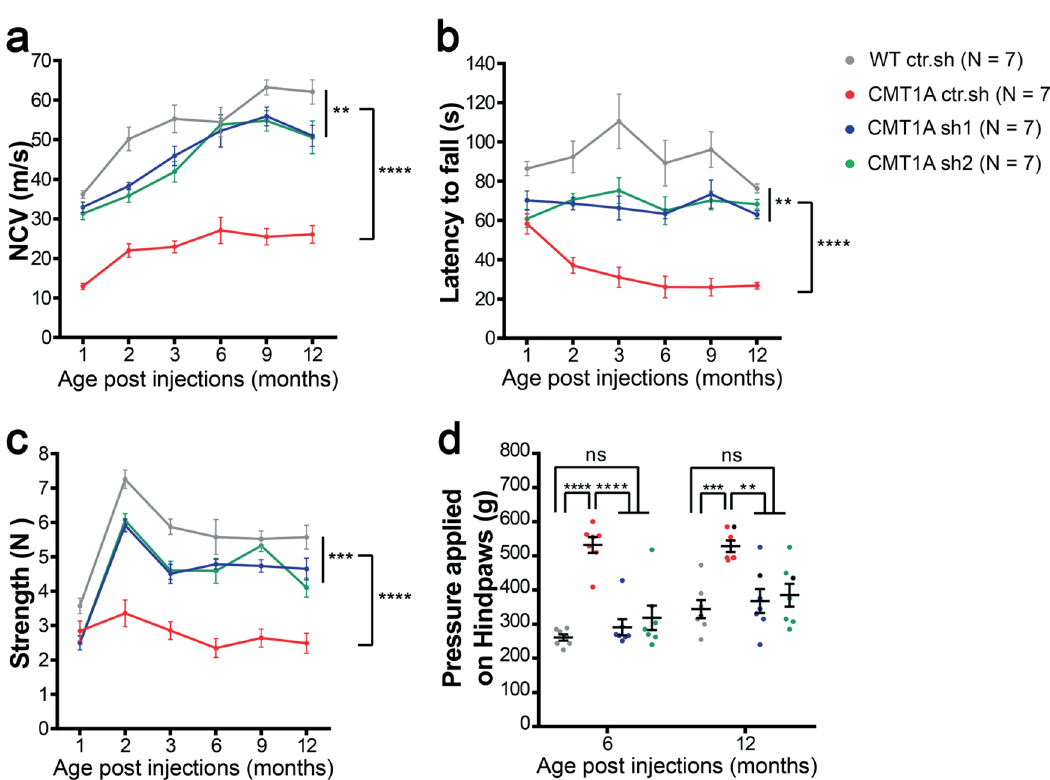
Fig. 5 Intra-nerve injections of AAV2/9-sh1 and -sh2 prevent motor and sensory defects on the long term in CMT1A rats. Graphs showing a NCV (meter/second), b Rotarod test (second), c grip test (Newton) one to twelve months after injection and d Randall Selitto test (gram) six and twelve months after injection in WT ctr.sh, CMT1A ctr.sh, CMT1A sh1 and CMT1A sh2 animals ( n = 7 animals per group). Statistical analysis shows two-way ANOVA followed by Tukey ’ s post hoc, two-sided, ( a , b and c ) comparing all groups paired two by two (** p < 0.01, *** p < 0.001, **** p < 0.0001, all p -values of two- sided multiple com p arison tests are available in Table S2) or one-way ANOVA followed by Tukey ’ s post hoc, two-sided, for six and twelve months post- injection in d . At six months post-injection, **** p < 0.0001 between WT ctr.sh and CMT1A ctr.sh, between CMT1A ctr.sh and CMT1A sh1, between CMT1A ctr.sh and CMT1A sh2; at twelve months post-injection, *** p = 0.0008 between WT ctr.sh and CMT1A ctr.sh, ** p = 0.0033 between CMT1A ctr.sh and CMT1A sh1, ** p = 0.0091 between CMT1A ctr.sh and CMT1A sh2; ns, not signi fi cant. Results are expressed as mean ± SEM. Source data are provided as a Source Data fi